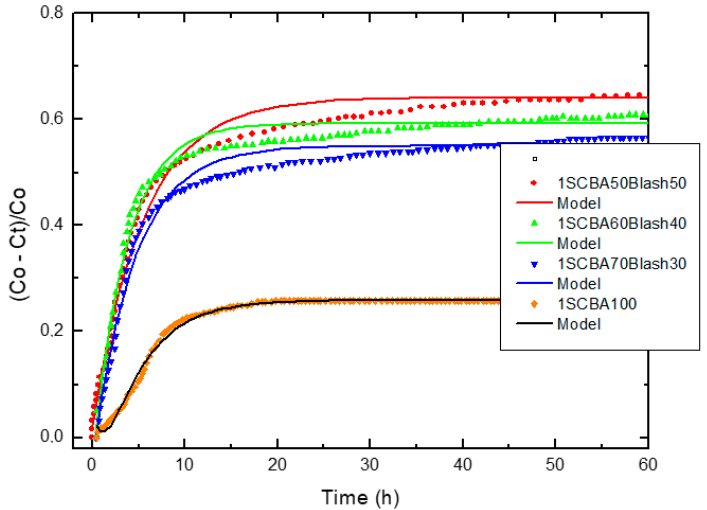
Figure 4. Relative loss of lime concentration versus reaction times for 1SCBA50BLAsh50, 1SCBA60BLAsh40, 1SCBA70BLAsh30 and 1SCBA100. ( Note : Black circle (experimental), solid line (model)).